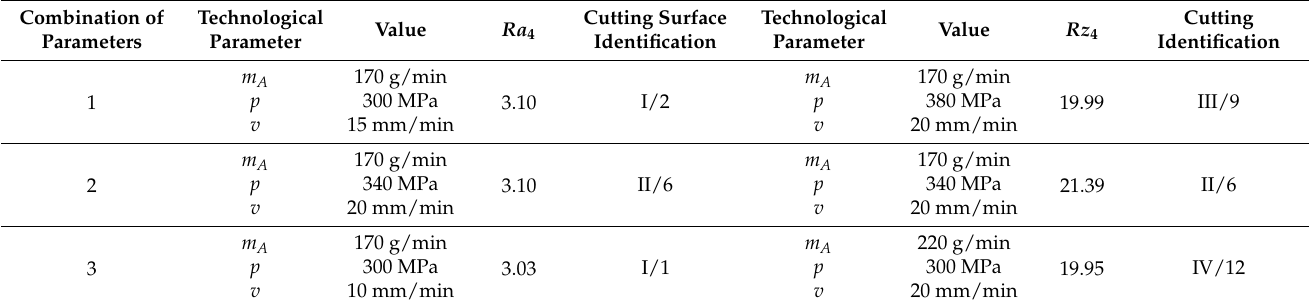
Table 4. Example of combinations of values of technological parameters for achieving approximately equal (average) roughness Ra 4 = 3.15; Rz 4 =